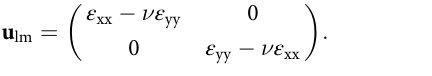
nonlinear susceptibility (Eq. (1)). Using a Poisson ratio of = 0.29 41 and an unstrained nonlinear susceptibility of χ ν MoS2 4.5 nm/V 32 , we determine the photoelastic tensor parameters of